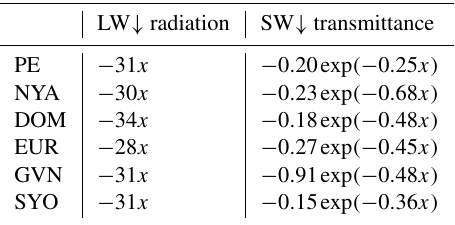
Table 2. Coefficients of the altitude dependence curves for the six AWSs as shown in Fig. 6. These equations indicate the change in LW ↓ radiation (W m -2 ) and SW ↓ transmittance (–) with an altitude change of x